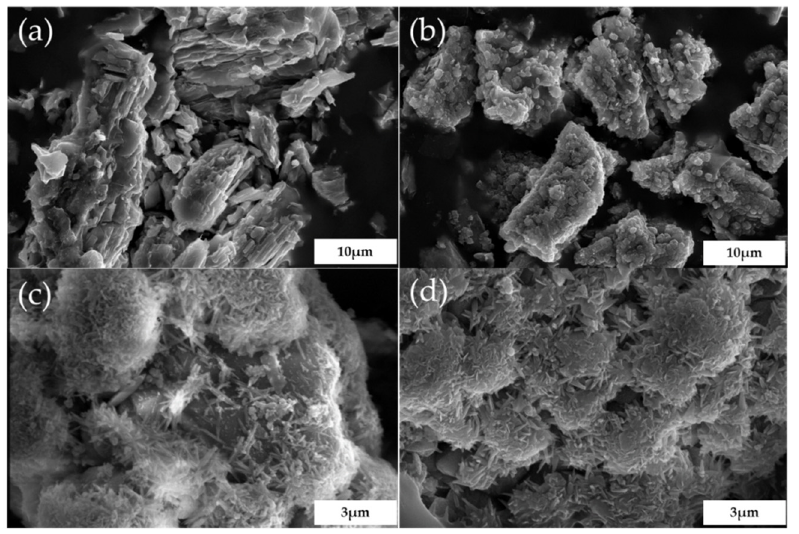
Figure 8. SEM morphology of AOD slag and carbonated AOD slag: ( a )—AOD raw slag; ( b )—60 °C AOD carbonated slag; ( c )—80 °C AOD carbonated slag; ( d )—100 °C AOD carbonated slag.